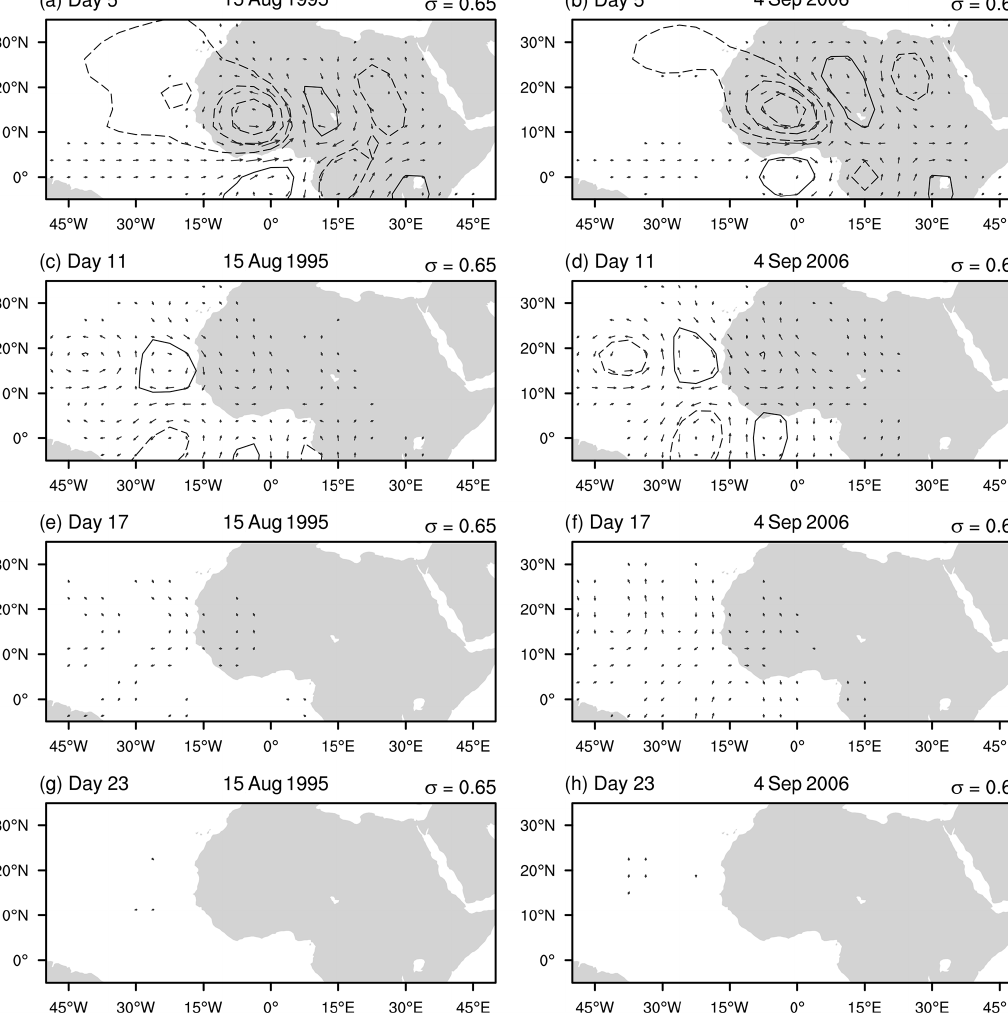
Figure 15. Streamfunction (interval 1 × 10 5 m 2 s − 1 with negative values dashed) showing the wave response within the basic state formed by the 15d average centered around 15 August 1995 (a, c, e, g) and 4 September 2006 (b, d, f, h) .